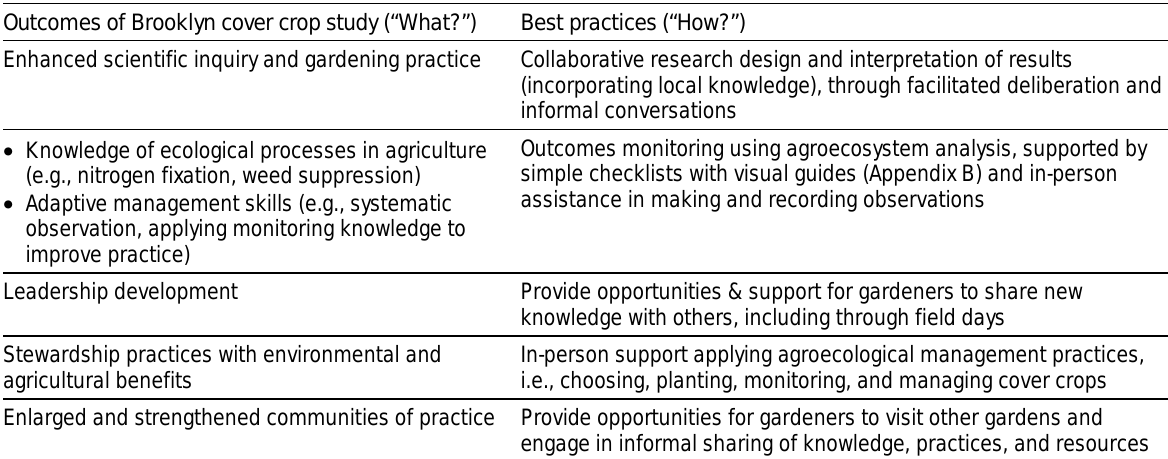
Table 2. Outcomes of Participatory Research on Cover Crops with Brooklyn Gardeners, and Design Choices and/or Practices that may have Contributed to Positive Outcomes Outcomes of Brooklyn cover crop study